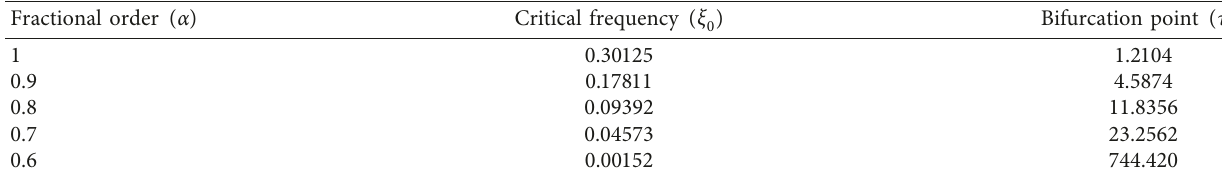
Table 1: ξ values and τ ∗ values for different fractional-order α 0 1